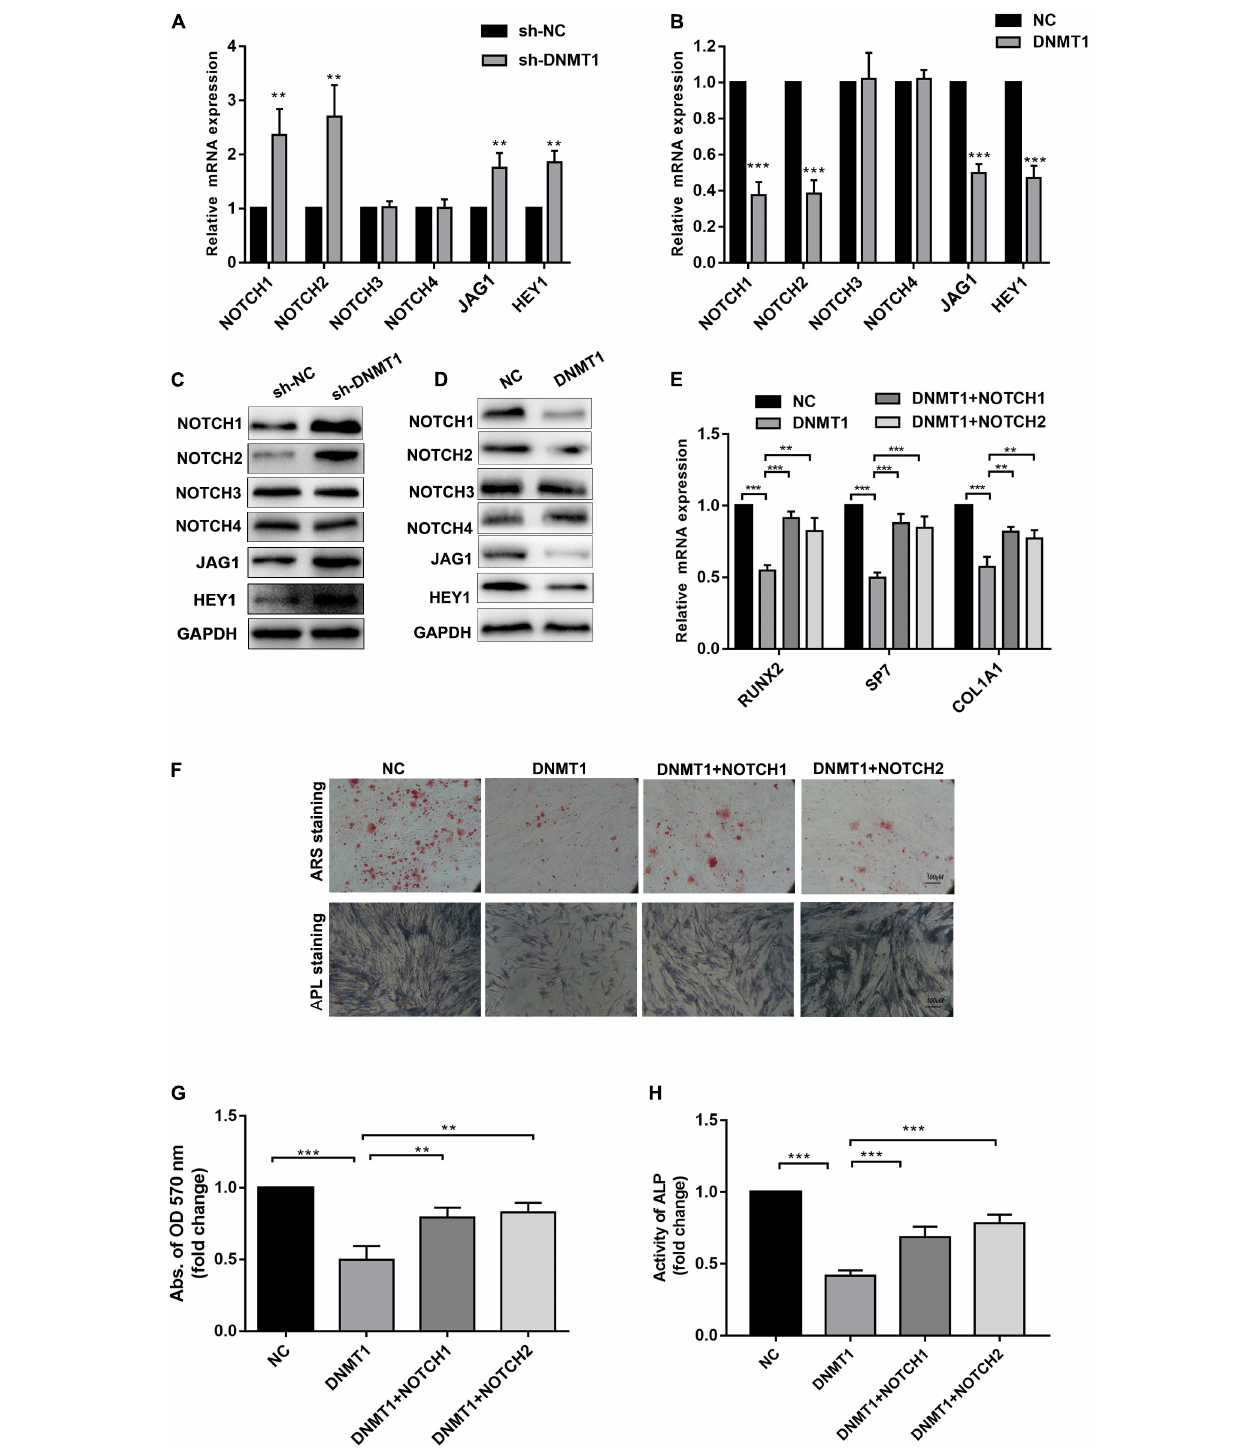
FIGURE 5 | (A,B) Human ADSCs were transfected with DNMT1 shRNA plasmid, expression of NOTCH1, NOTCH2, NOTCH2, NOTCH3,NOTCH4, JAG1, HEY1, were determined by Western blot and RT-qPCR. (C,D) hADSCs were transfected with DNMT1 overexpression plasmid, expression of NOTCH1, NOTCH2, NOTCH2, NOTCH3, NOTCH4, JAG1, HEY1, were determined by Western blot and RT-qPCR. (E) DNMT1 overexpressed hADSCs were transfected with NOTCH1 or NOTCH2 overexpression plasmids, expression of RUNX2, SP7, and COL1A1 were determined by Western blot and RT-qPCR. (F–H) DNMT1 stably overexpressed hADSCs were transfected with NOTCH1 and NOTCH2. After differentiation medium for 14 days, Alizarin red staining and ALP staining showed mineralized nodule formation, ALP activity and quantification of Alizarin red staining by spectrophotometry were determined. Data are shown as means ± SD. ** p < 0.01, *** p < 0.001.